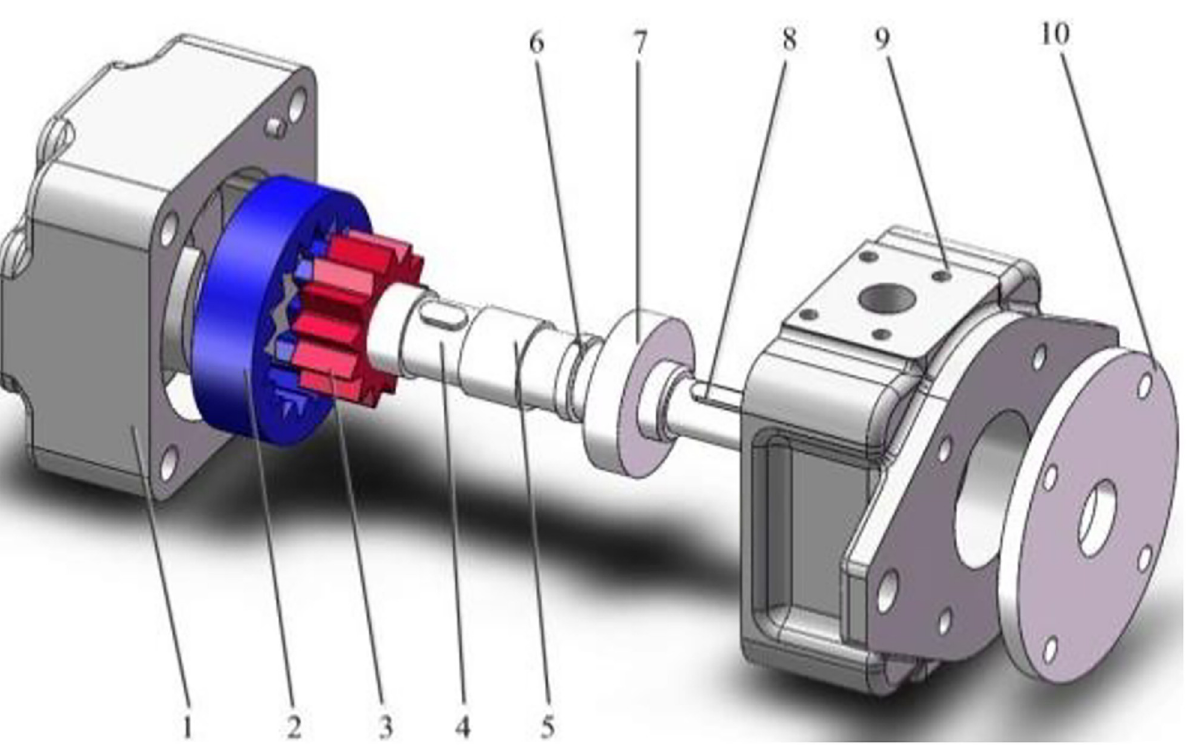
Fig 3. Exploded view of three-dimensional assembly. 1-pump body; 2-internal gear ring; 3-external gear; 4-gear shaft; 5-sliding bearing; 6-bearing retaining ring; 7-rolling gearing; 8-ordinary flat key; 9-pump cover; 10-bearing cover.